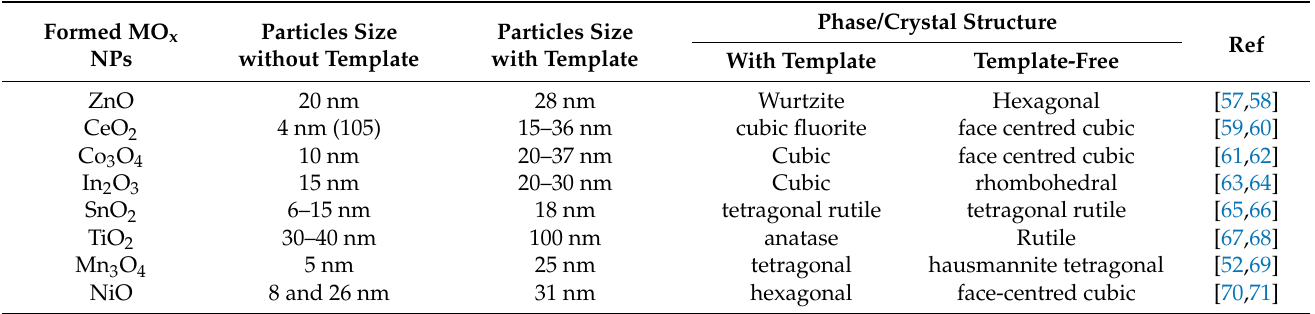
Table 1. Summary of matrix-assisted synthesis impact on grain size beside crystal structure of se- lected MOx nanomaterials [56].